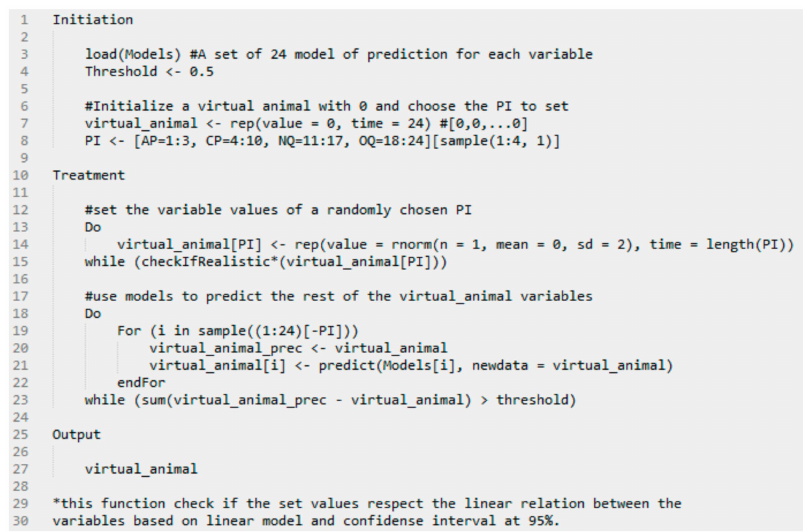
Figure A1. Algorithm to generate a virtual animal. The pseudo code was inspired from the R